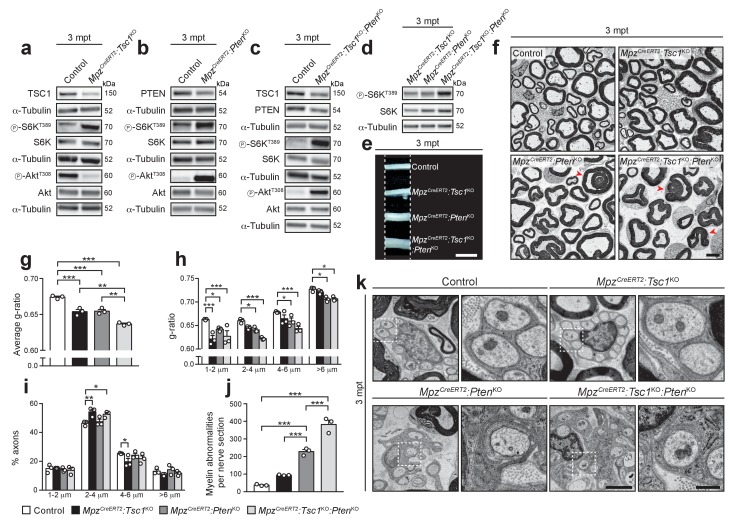
Inducible deletion of TSC1 and/or PTEN in adult mice reactivates myelin growth.(a–d) Western blot analysis, 3 mpt sciatic nerve lysates from control, MpzCreERT2:Tsc1KO, MpzCreERT2:PtenKO, and MpzCreERT2:Tsc1KO:PtenKO mice (n = 3 mice/genotype). Quantification: Figure 5—figure supplement 1a–d. Note that exposure times for the three phospho-AktT308 western blots in a, b, and c were adjusted per membrane to avoid saturation of signals. (e) Macroscopic appearance of 3 mpt sciatic nerves from controls and mutants. Scale bar: 2.5 mm. (f) Electron micrographs of sciatic nerve cross sections from 3 mpt controls and mutants (n = 3 mice/genotype). Scale bar: 4 μm, refers to whole panel. (g–i) G-ratio, g-ratio distribution, and axon diameter distribution of 3 mpt control and mutant sciatic nerves. At least 400 sorted fibers per sample were analyzed (random EM fields). Bar height: Mean; error bars: s.e.m. (n = 3 mice/genotype; g, one-way ANOVA with Tukey’s multiple comparisons test, F(3,8) = 52.91, p<0.0001, pcontrol vs TSC1KO = 0.0006, pcontrol vs PTENKO = 0.0008, pcontrol vs doubleKO <0.0001, pTSC1KO vs doubleKO = 0.0018, pPTENKO vs doubleKO = 0.0014; h, two-way ANOVA with Tukey’s multiple comparisons test, F(9,32) = 2.699, p=0.0185, p1-2 μm control vs TSC1KO <0.0001, p1-2 μm control vs PTENKO = 0.0269, p1-2 μm control vs doubleKO <0.0001, p2-4 μm control vs PTENKO = 0.0453, p2-4 μm control vs doubleKO <0.0001, p4-6 μm control vs PTENKO = 0.0485, p4-6 μm control vs doubleKO = 0.0001, p>6 μm control vs PTENKO = 0.0212, p>6 μm control vs doubleKO = 0.0299; (i), two-way ANOVA with Tukey’s multiple comparisons test, F(9,32) = 4.055, p=0.0015, p2-4 μm control vs TSC1KO = 0.0022, p2-4μm control vs doubleKO = 0.0188, p4-6 μm control vs TSC1KO = 0.0357). (j) Myelin abnormalities per sciatic nerve cross sections at 3 mpt. Bar height: Mean; error bars: s.e.m. (n = 3 mice/genotype, one-way ANOVA with Tukey’s multiple comparisons test, F(3,8) = 123.3, p<0.0001; pcontrol vs PTENKO <0.0001, pcontrol vs doubleKO <0.0001, pPTENKO vs TSC1KO = 0.0006, pPTENKO vs doubleKO = 0.0002). (k) Electron micrographs of 3 mpt sciatic nerves showing exemplary Remak bundles and enlarged details (dashed square). (n = 3 mice/genotype). Scale bar: 2 μm (left), 500 nm (right). *p<0.05, **p<0.01, ***p<0.001.